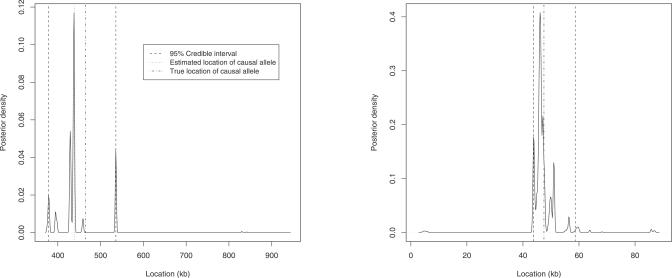
Posterior Density of Location of Causal Allele and 95% Credible IntervalsCredible intervals (95%) of causal location for two datasets simulated with 1.8 and 2.4 GRR(Aa) and all other simulation parameters at default values. The credible intervals are 150 kb and 15 kb wide, respectively.